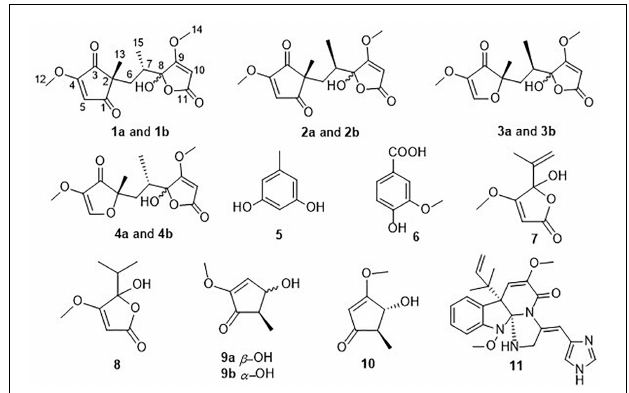
FIGURE 1 | Chemical structures of compounds 1 – 11